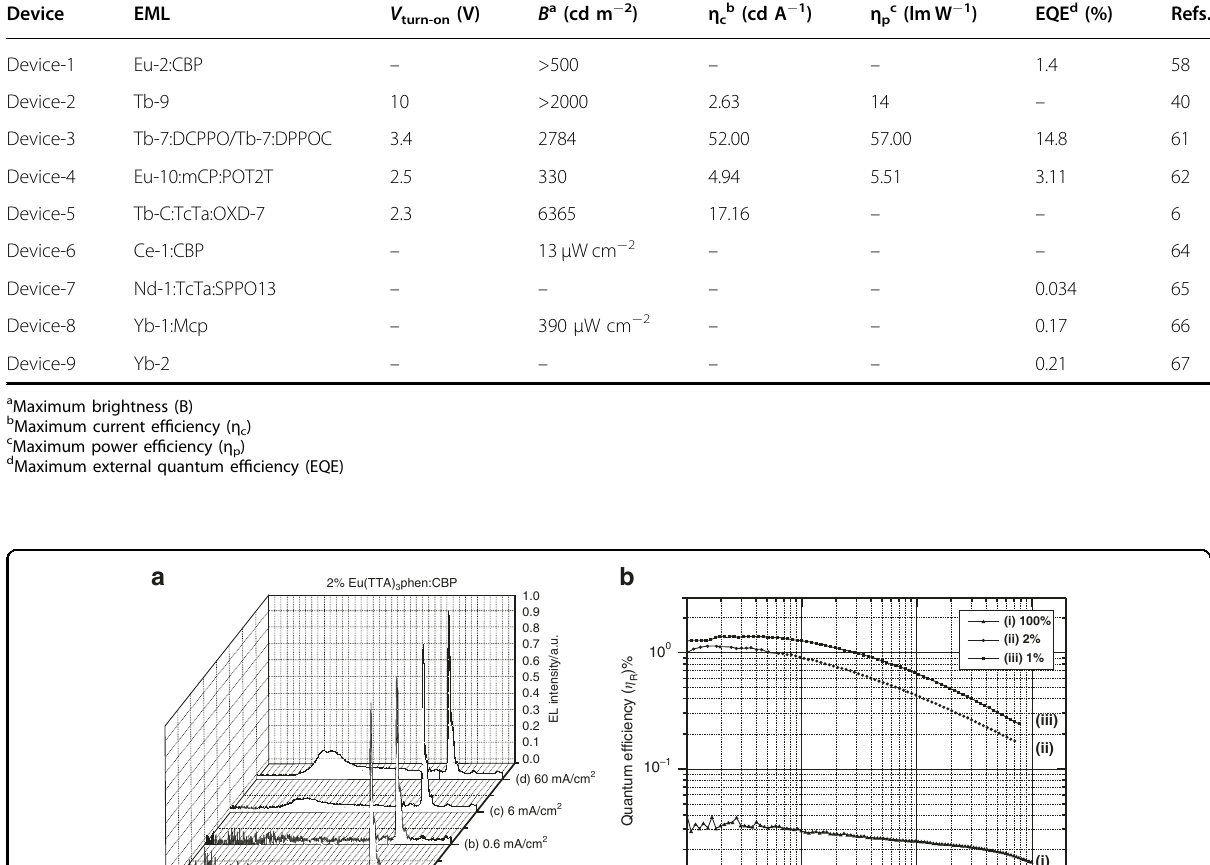
Table 3 The EL performances of the representative RE complexes based devices Device